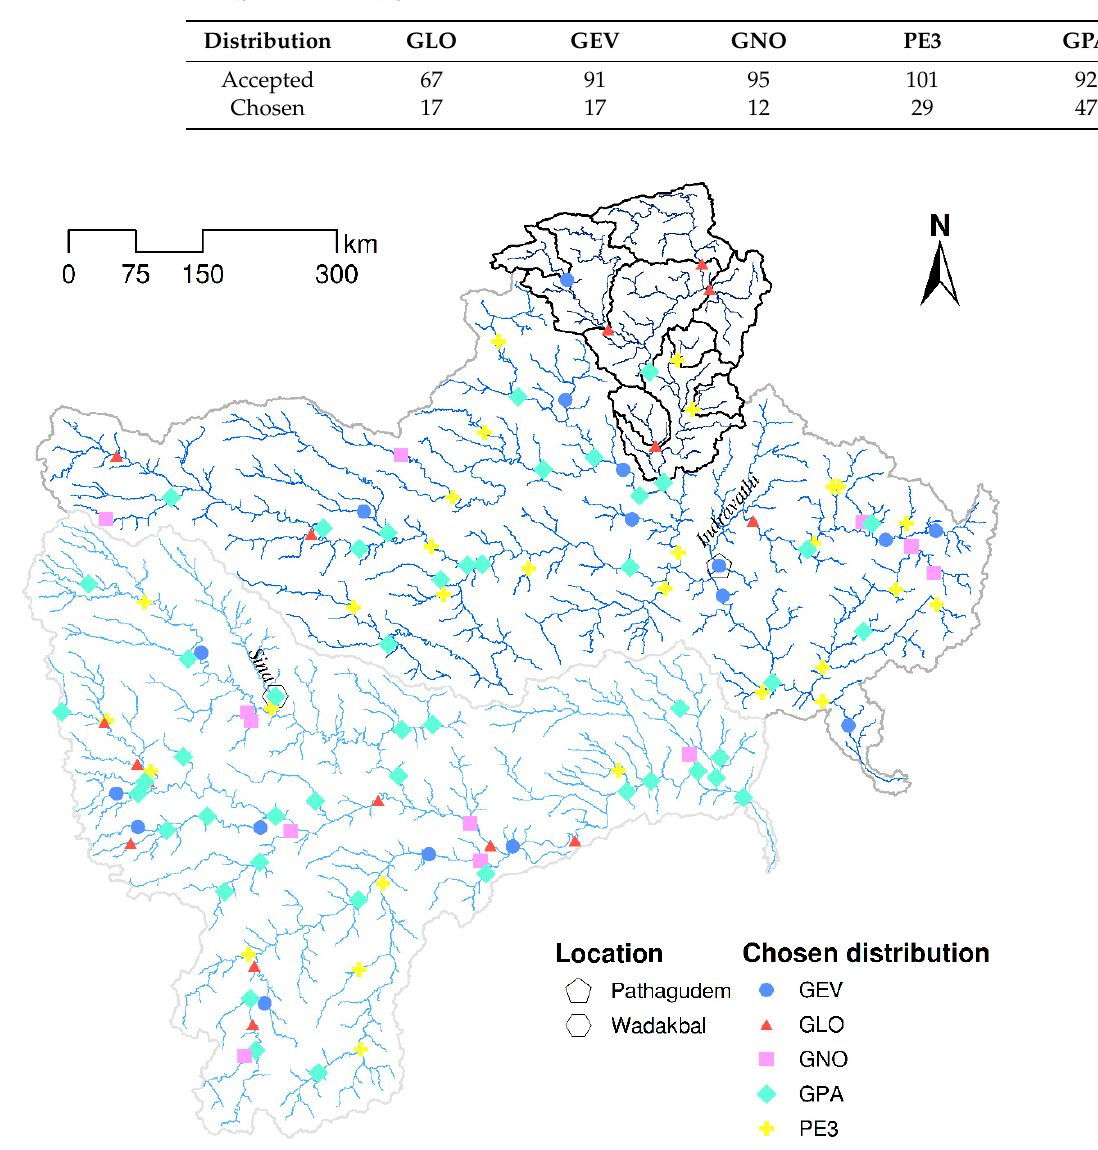
Figure 3. Hosking–Wallis distribution test results over the Krishna and Godavari basins. Wainganga sub-catchments are outlined in black.